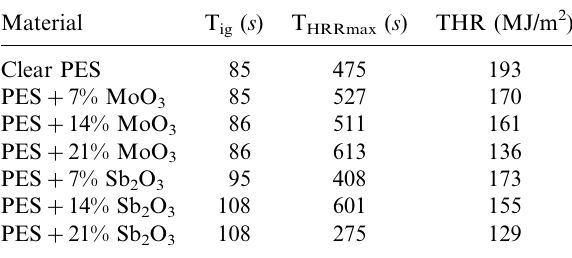
Table 4. Thermo-kinetic properties of polyester materials containing Polimal 1033 APy unmodified and modified with inorganic oxides under ignition conditions for the external heat flux of 30 kW/m